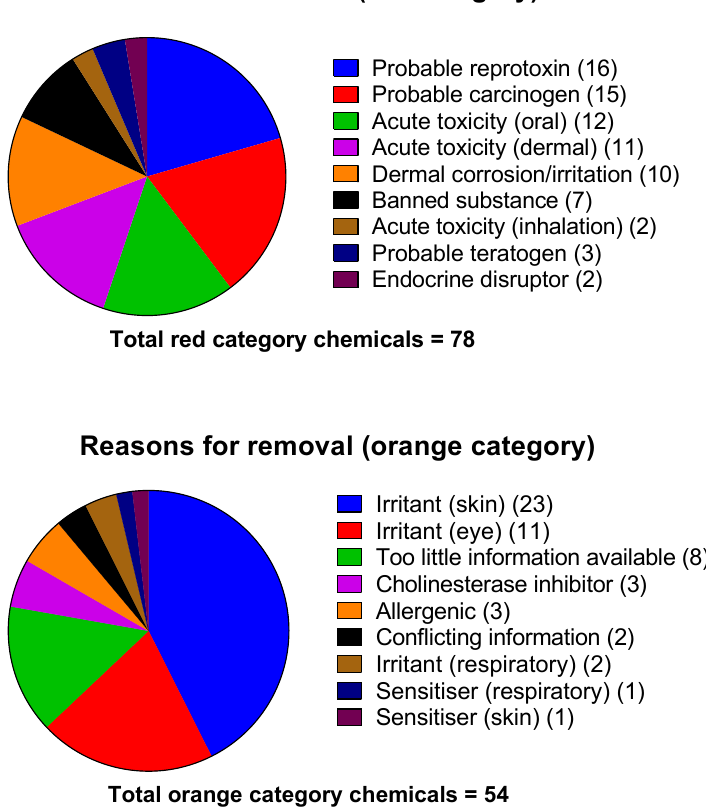
Figure 2. Exclusion characteristics of red and orange category chemicals, and the source/most-com- mon commercial use of the green category chemicals.